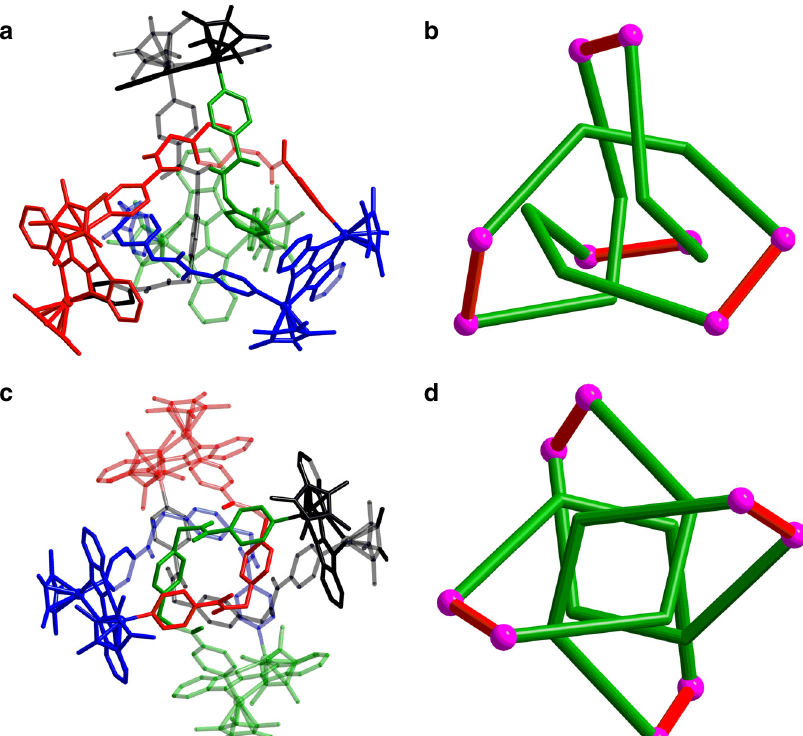
Fig. 7 Single-crystal X-ray structure of 3 . The reduced representation with four crossings ( a ) and the four-fold symmetry representation ( c ) of 3 , and simpli fi ed structures of the reduced representation with four crossings ( b ) and the four-fold symmetry representation ( d ) of 3 in which sticks connect the rhodium